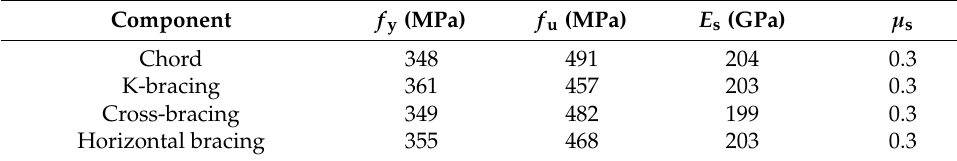
Table 2. Mechanical properties of steel.